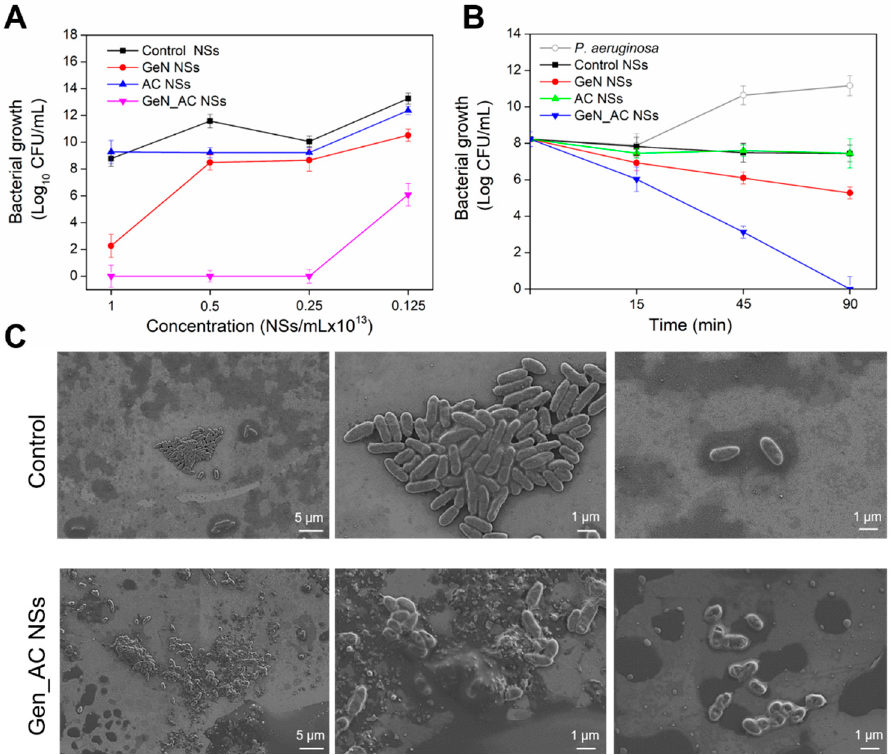
Figure 2. ( A ) P. aeruginosa growth after 24 h incubation with different concentrations of control, AC, GeN and GeN_AC NSs; ( B ) Time-kill kinetics of control, AC, GeN and GeN_AC NSs; ( C ) Scanning electron microscopy images of P. aeruginosa in absence and presence of GeN_AC NSs (0.25 × 10 13 NSs mL − 1 ) at different magnification.